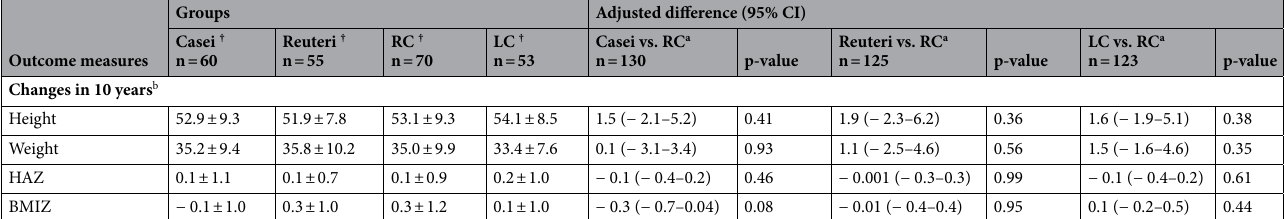
Table 2. Long term effects on growth in adolescents who consumed low lactose milk in their childhood. BMIZ body mass index-for-age z-score, CI confidence interval, HAZ height-for-age z-score. † Mean ± SD (all such values). a General linear model, adjusted for age, gender, and living area. b Changes between the end of intervention and after 10-years follow up measurements.